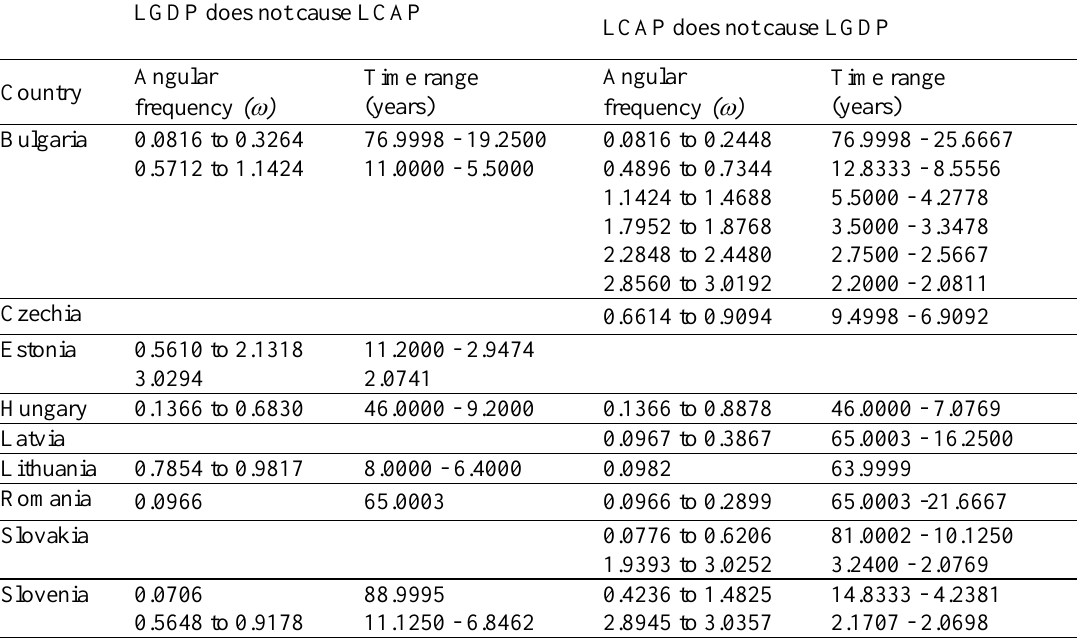
Table 5. Causality from the Frequency Domain